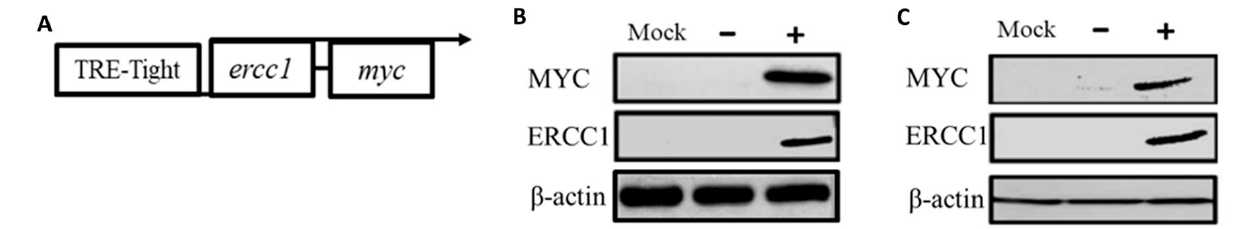
Figure 1. Characterization of Tet-on ERCC1 Colorectal cancer cell lines. ( A ) Schematic diagram of the Tet-on system for assessing doxycycline-inducible ERCC1 expression. ( B ) HCT116 and ( C ) COLO205 cells were categorized as wild type (WT), Tet-on-ERCC1-(no doxycycline treatment) or Tet-on-ERCC1+ (treated with 2 μ g/mL doxycycline). Cytoplasmic extrusion mass was collected 24 h post-treatment and used for exogenous ERCC1-MYC tag detection with anti-MYC tag or ERCC1 antibodies.